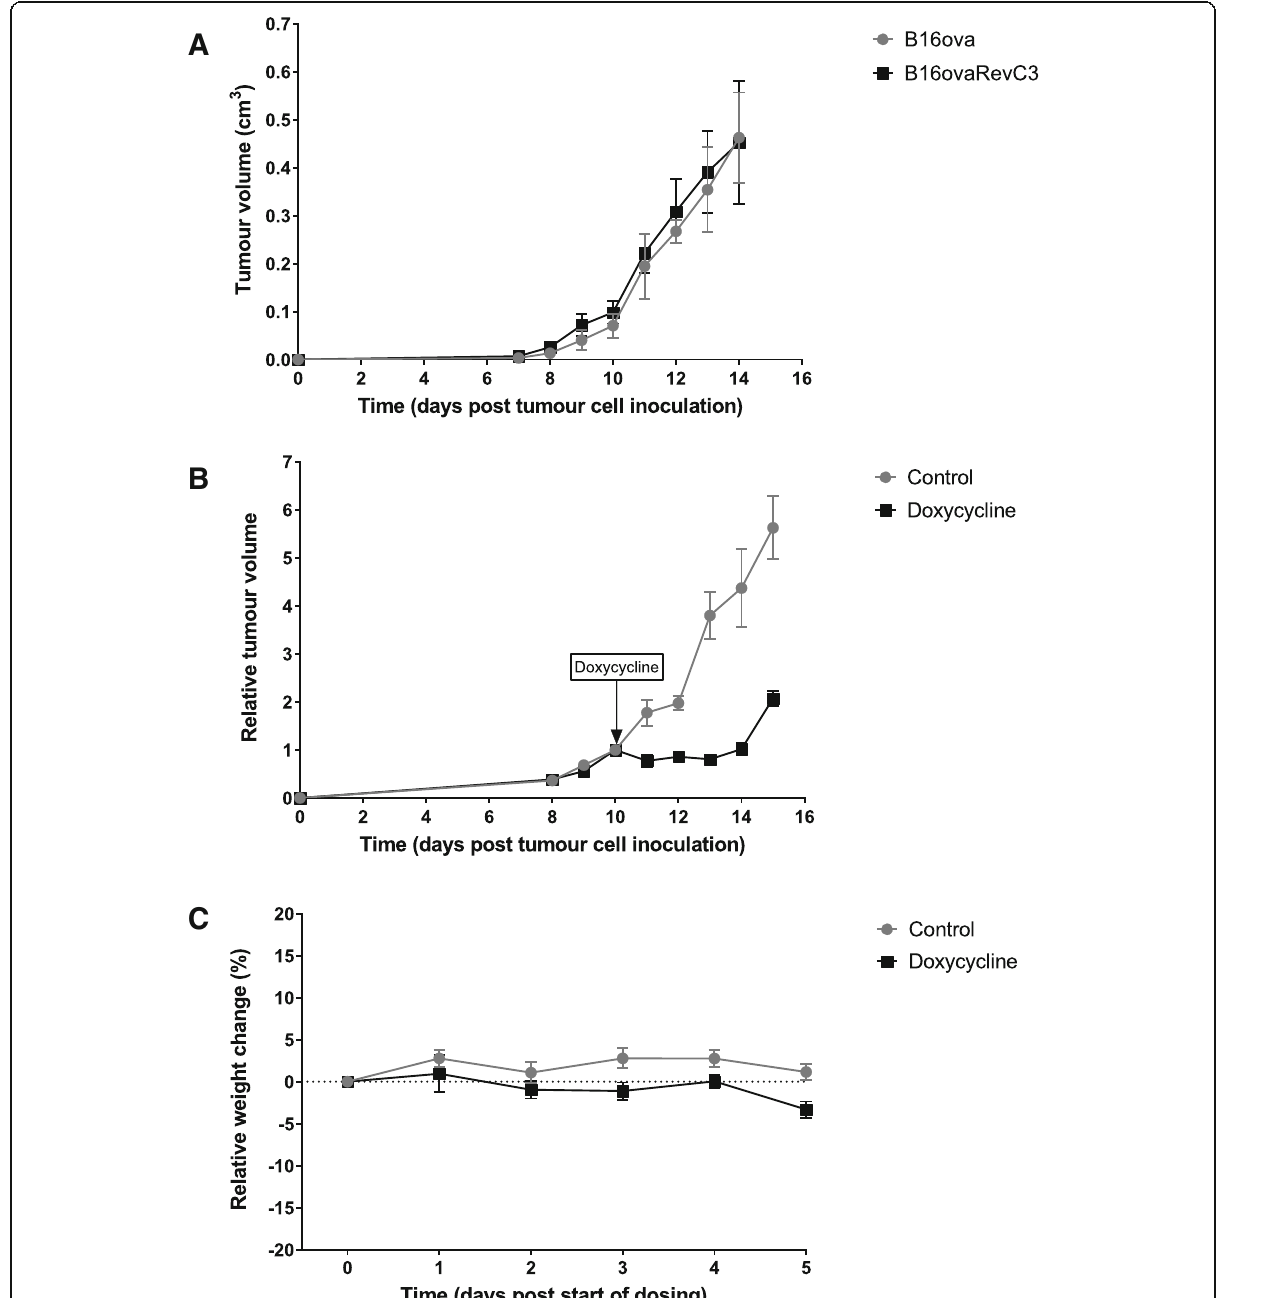
Fig. 3 In vivo tumour growth of B16ova and B16ovaRevC3 xenografts. a Similar tumour growth of B16ova ( n = 6) and B16ovaRevC3 ( n = 6) xenografts without doxycycline administration. b Significantly reduced tumour growth of B16ovaRevC3 xenografts was observed in response to doxycycline compared with control B16ovaRevC3 tumours, n = 6 per group (at day 11, p < 0.01, multiple t tests) and persisted for the duration of doxycycline dosing ( p < 0.001, multiple t tests). c Mouse weight relative to start of dosing with doxycycline. No observable toxicities were detected based on relative